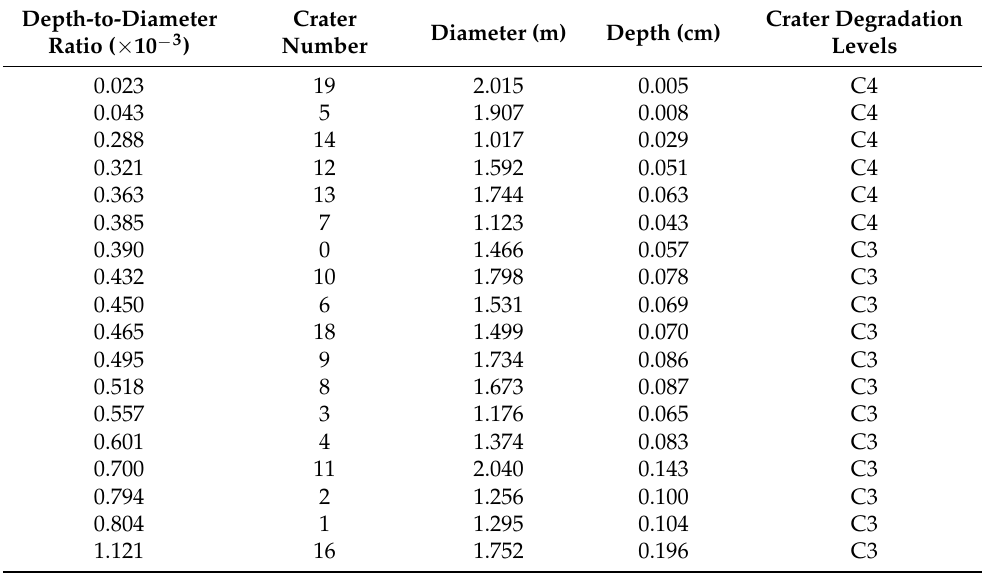
Table 2. Diameter-to-depth ratio of the impact crater in the third lunar day experiment area from the Yutu-2